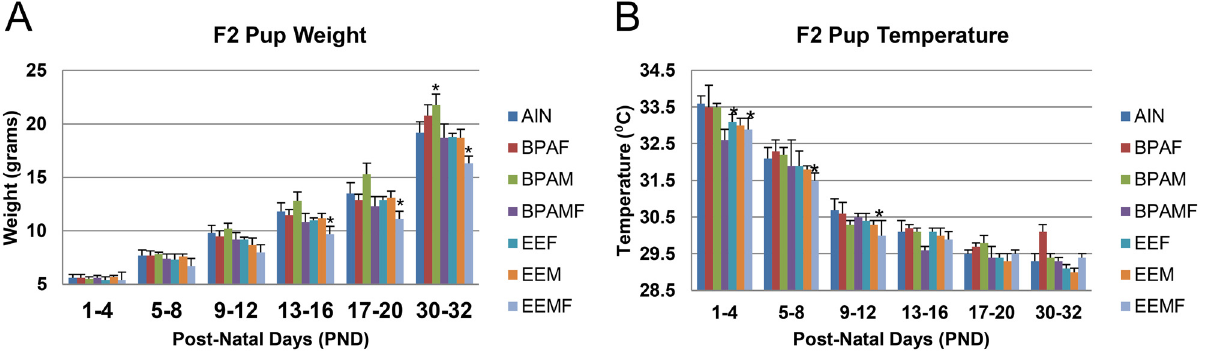
Fig 4. Effects of developmental EDC exposure of parents on body weight gain and body temperature of pups. A, Body weight of neonatal to weanling offspring. B, Body temperature of neonatal to weanling offspring. Treatment groups that differ from control pairs: * , P value range = 0.01 to